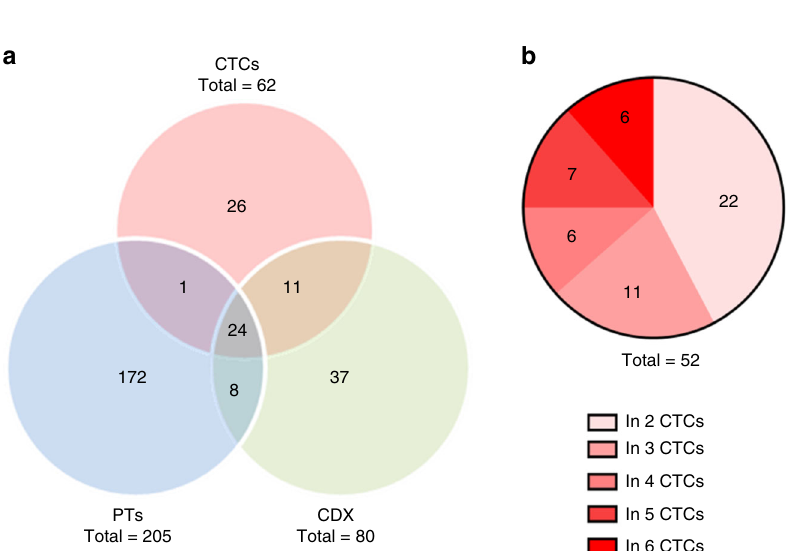
Fig. 4 Genomic analysis of CTCs. a Genetic relationship between CTCs, primary tumor, and the CDX. Venn diagram showing the overlap of somatic variants detected among CTCs, the primary tumor and the CDX. b Number of somatic variants in CTCs according to their